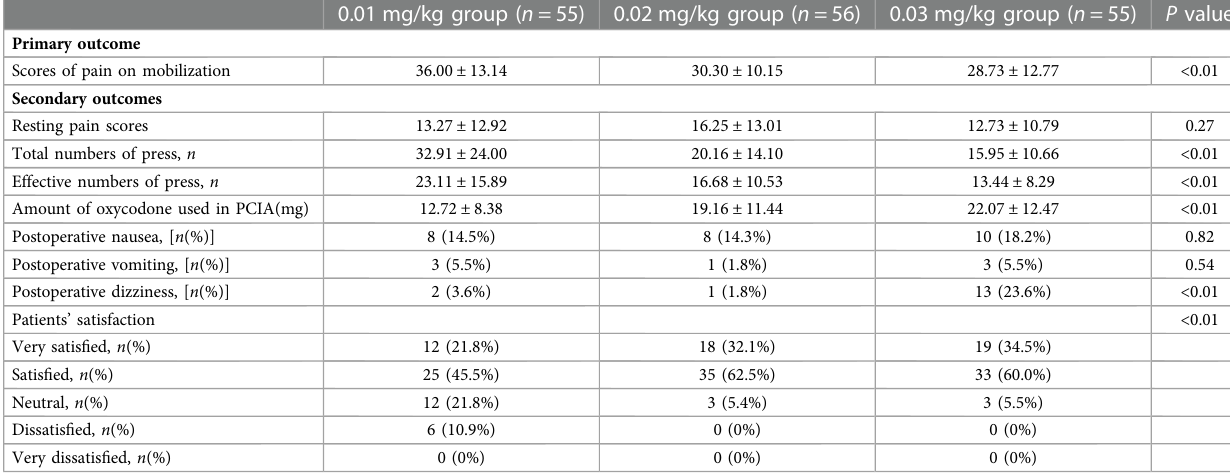
TABLE 2 Primary outcome and secondary outcomes among three